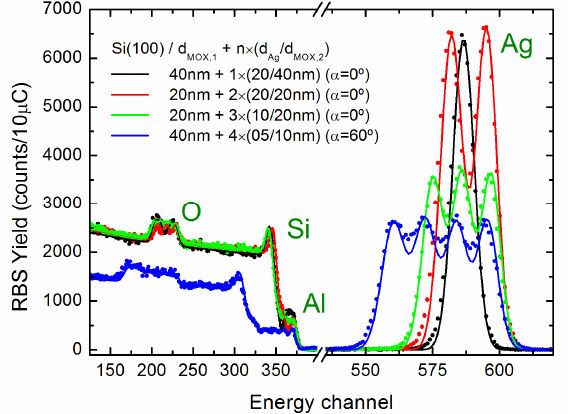
Figure 1. RBS experimental (dots) and simulated (solid lines) spectra from representative multilayer coatings (see label for each structure). The multilayer structure can be extracted from the modulation of the Ag signal. In order to resolve the thinnest Ag layers (5 nm), the incidence angle (α) of the probing He + beam with respect to the surface normal was increased to 60° (larger effective layer thickness). The agreement between the simulated and experimental data indicates the good quality of the interfaces.